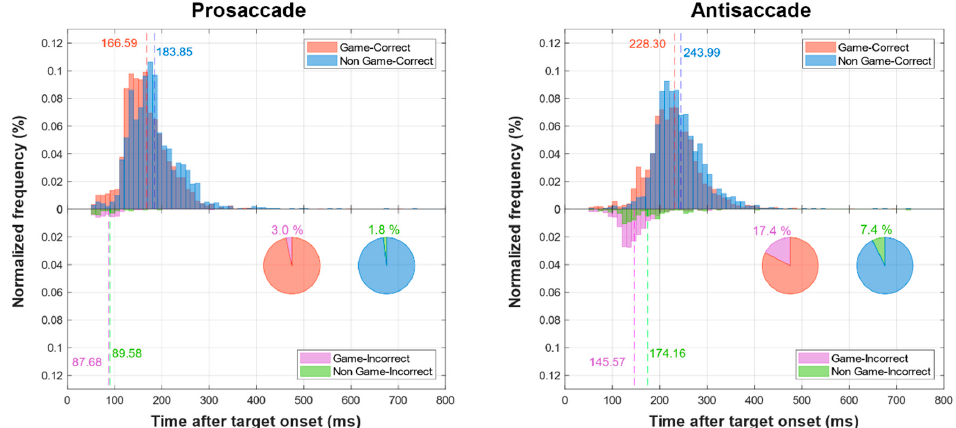
Figure 3. Normalized frequency histograms of the prosaccade ( left ) and the antisaccade ( right ) task. Histograms above the zero-line represent the RT distribution of correct trials, and those below represent incorrecttrials. ThedistributionsofRToftheVGPgroupareshowninred(correct)andpurple(incorrect), and those of the NVGP group are shown in blue (correct) and green (incorrect). Dotted lines indicate mean RT values. Pie charts in the lower right corner summarize the error rates of VGP ( left ) and NVGP ( right ) group,